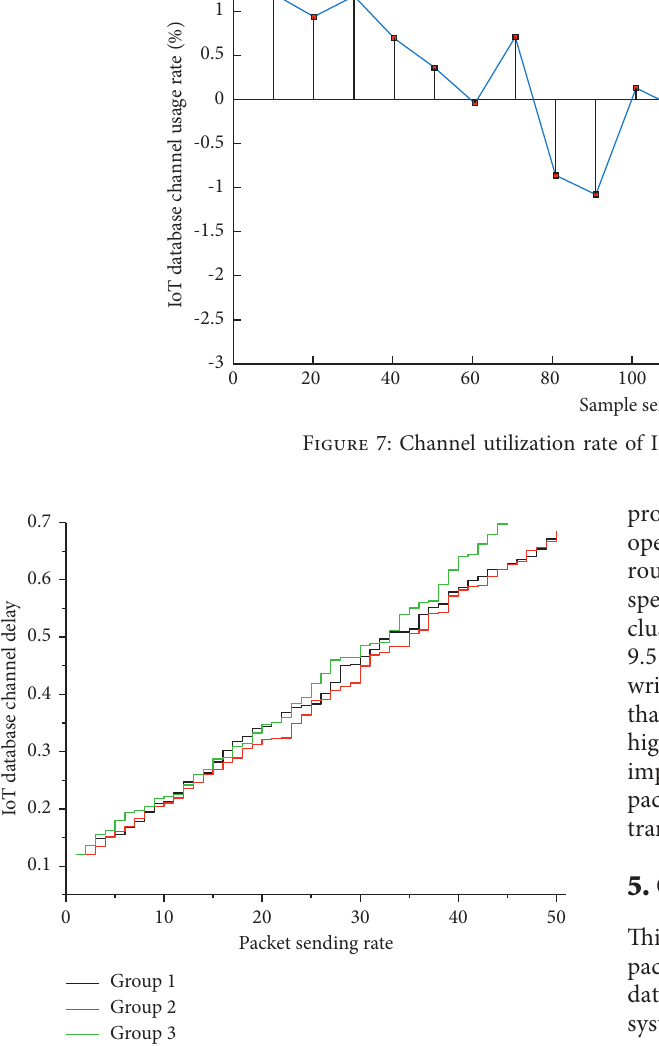
Figure 8: Comparison of data latency of Internet of Things da- tabase